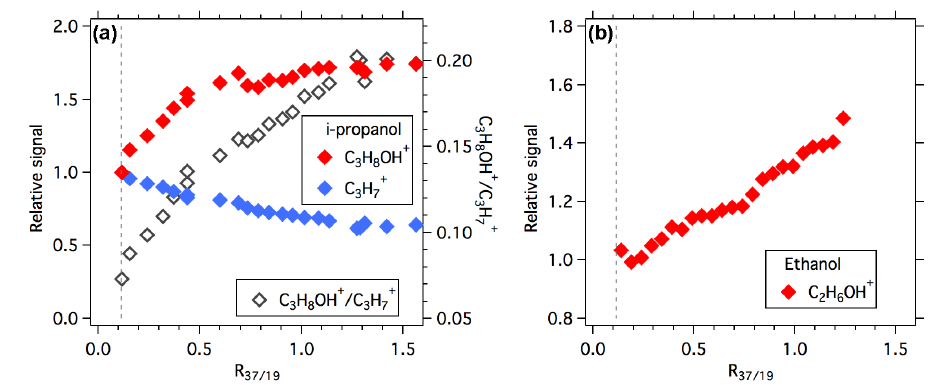
Figure 6. (a) Normalized signals relative to dry conditions for protonated and dehydrated ions of isopropanol as a function of R 37 / 19 ratios. The vertical dashed line indicates the level of R 37 / 19 under dry conditions. (b) Normalized signals relative to dry conditions for protonated ion of ethanol as a function of R 37 / 19